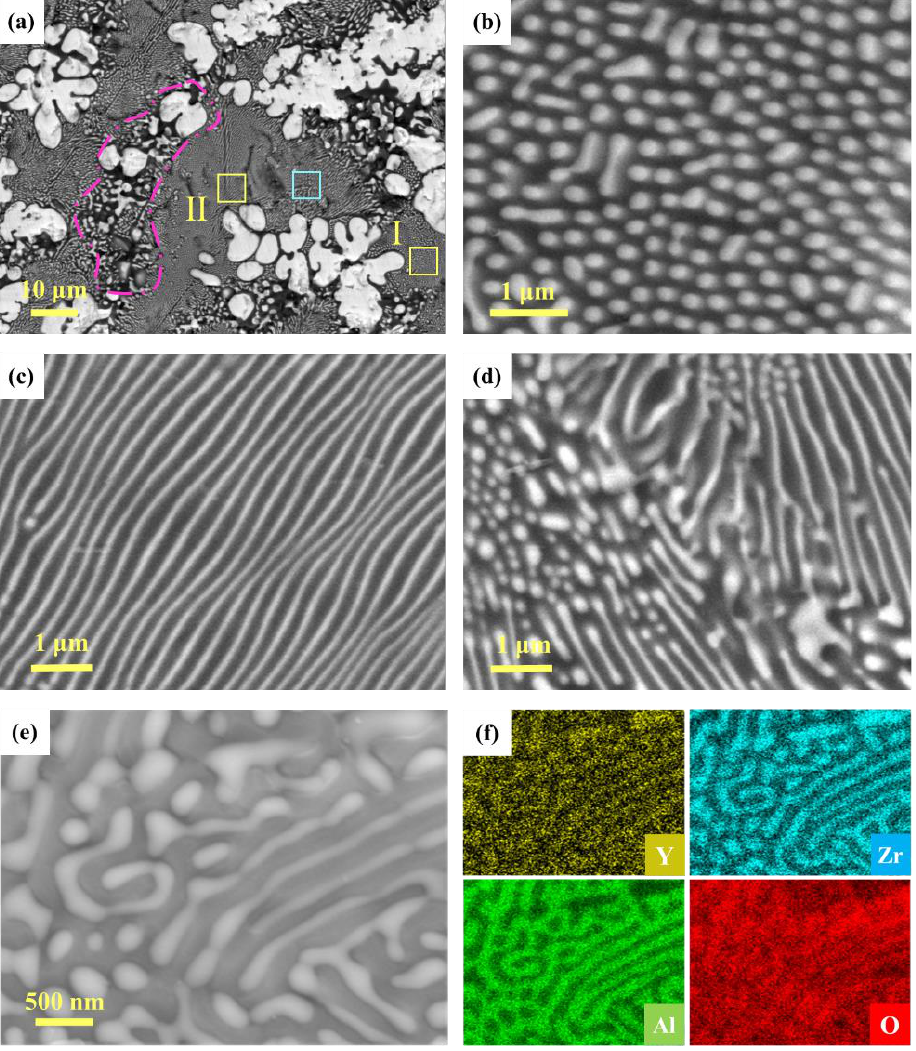
Figure 4. ( a ) SEM image of the molten zone of FS-102 (see the area surrounded by the pink line for colony structure). ( b – c ) The microstructure of rod and lamellae structures (see yellow rectangle I and yellow rectangle II in ( a )). ( d ) Enlargement of the area in the blue rectangle in ( a ). ( e ) SEM image and ( f ) EDS maps of the molten zone of FS-102.